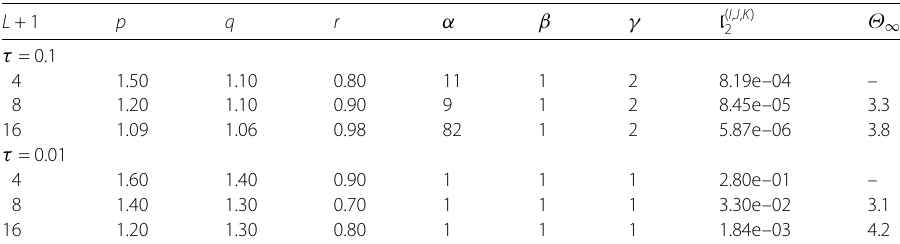
Table 1c Errors for the EF-EEG-TOCS in Example 5.1 L + 1 p τ = 0.1